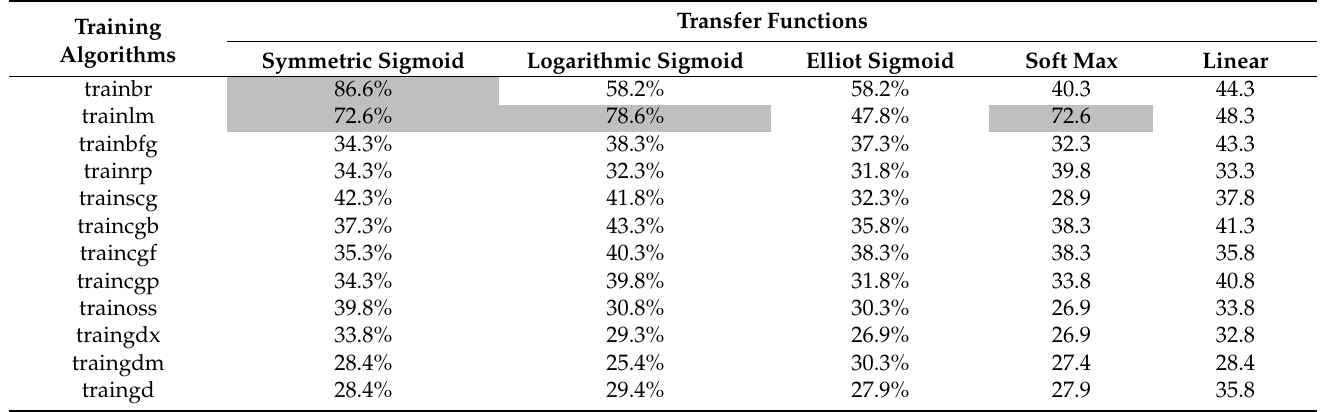
Table 3. Prediction efficiency in percentage for each tested case. Grey shade indicates the highest prediction efficiencies.